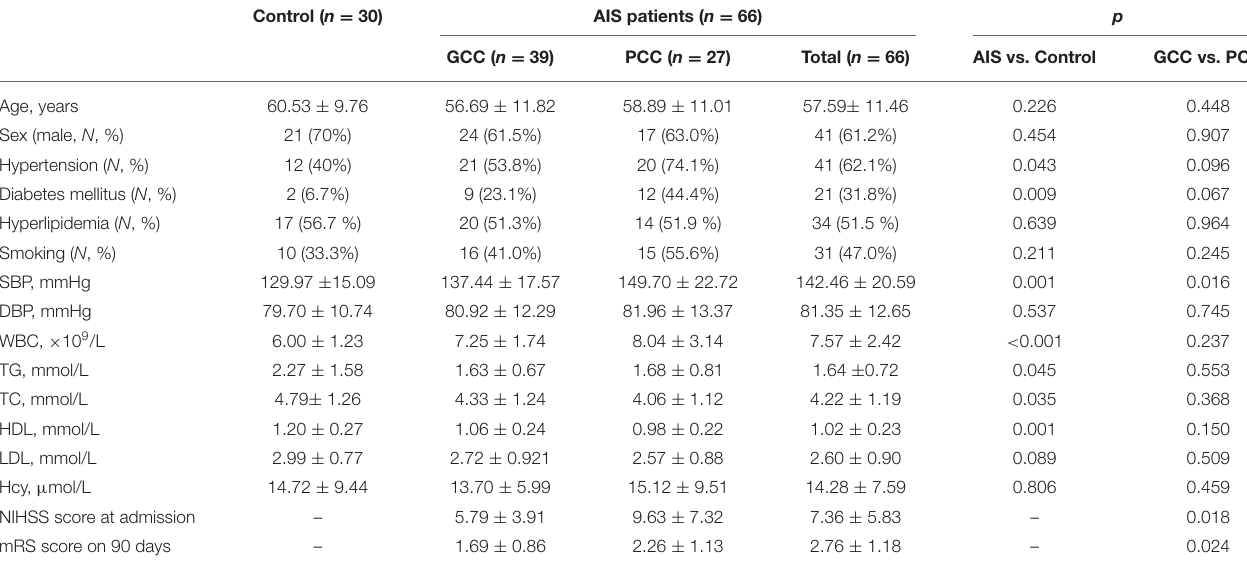
TABLE 1 | General characteristics of control and patients with AIS in the discovery stage. Control ( n =